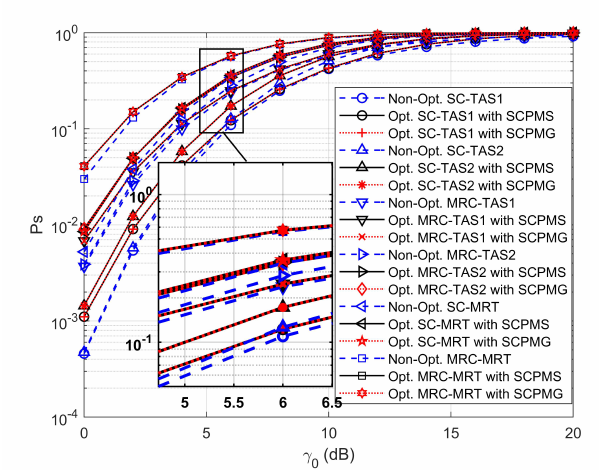
Figure 13. Optimization of Ps with different